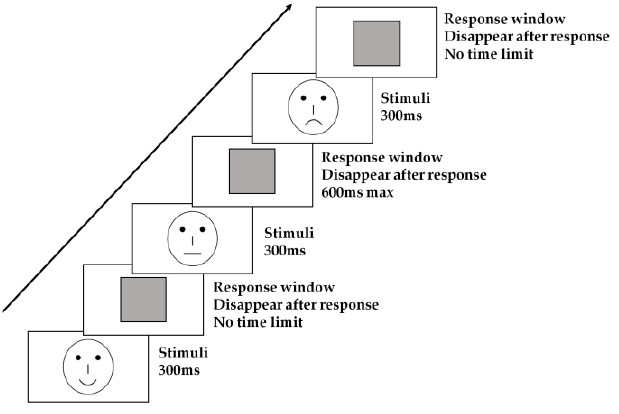
Figure 1. Flow chart of the experimental